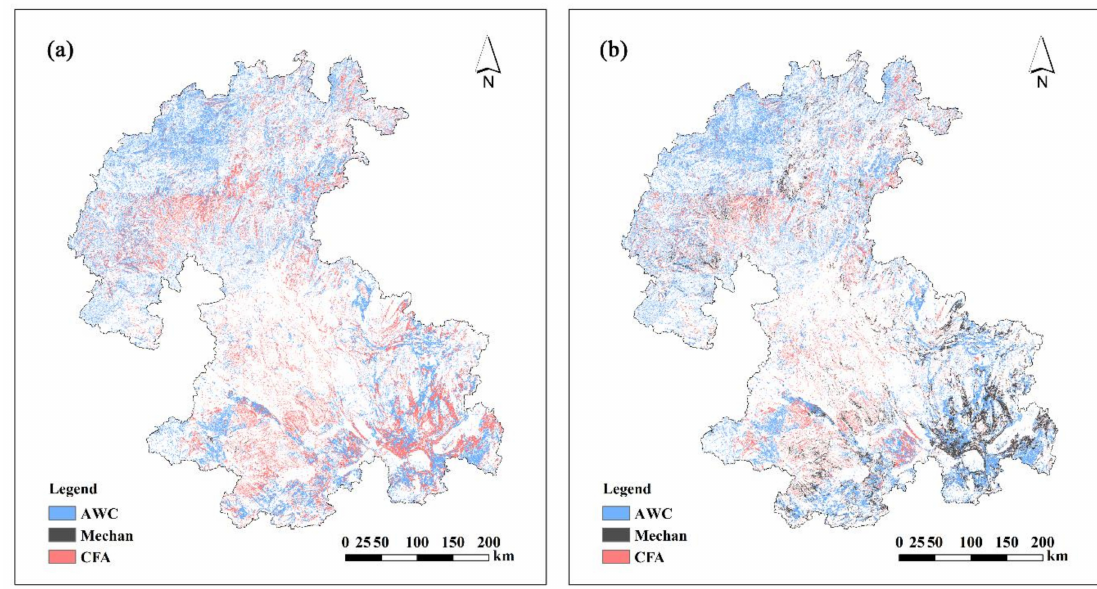
Figure 6. ( a ) Dominant key factors distribution in 2000; ( b ) Dominant key factors distribution in 2015